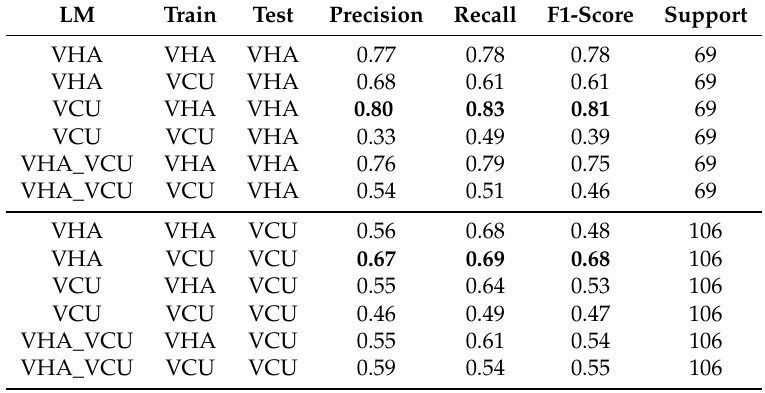
Table 5. Transfer Learning Results for Model-2. First six rows for VHA test-set models and last six rows are for VCU test-set. Results reported are macro-averaged. Support indicated the total number of samples in test-sets. LM: Language Model. Bold values indicates the best results generated. LM Train Test